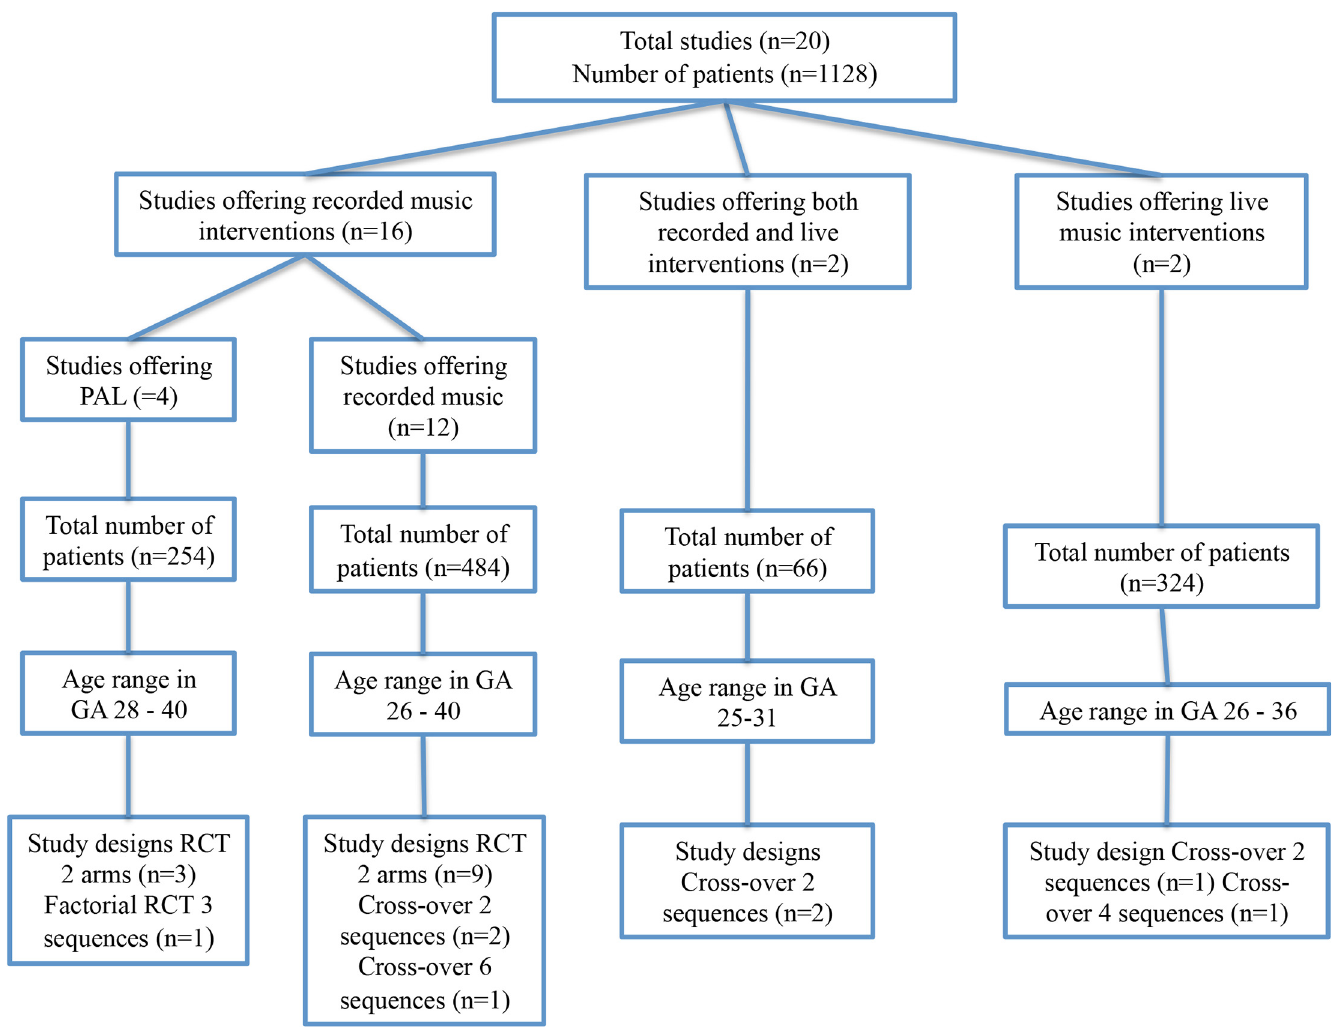
Fig 1. Characteristics of included